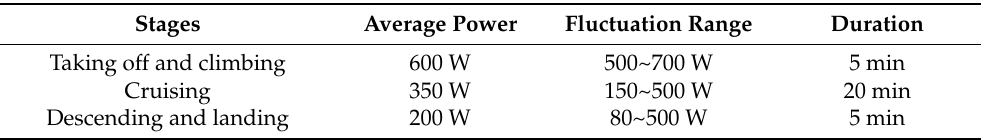
Figure 16. The hardware ‐ in ‐ loop testing platform based on the RCP platform for the UAV hybrid power system. Table 3. The requirements of the load power for the UAV.